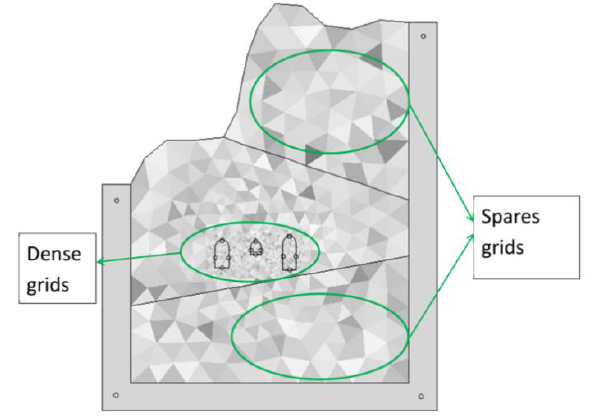
Figure 2. Computational model generated in optimized DDARF.